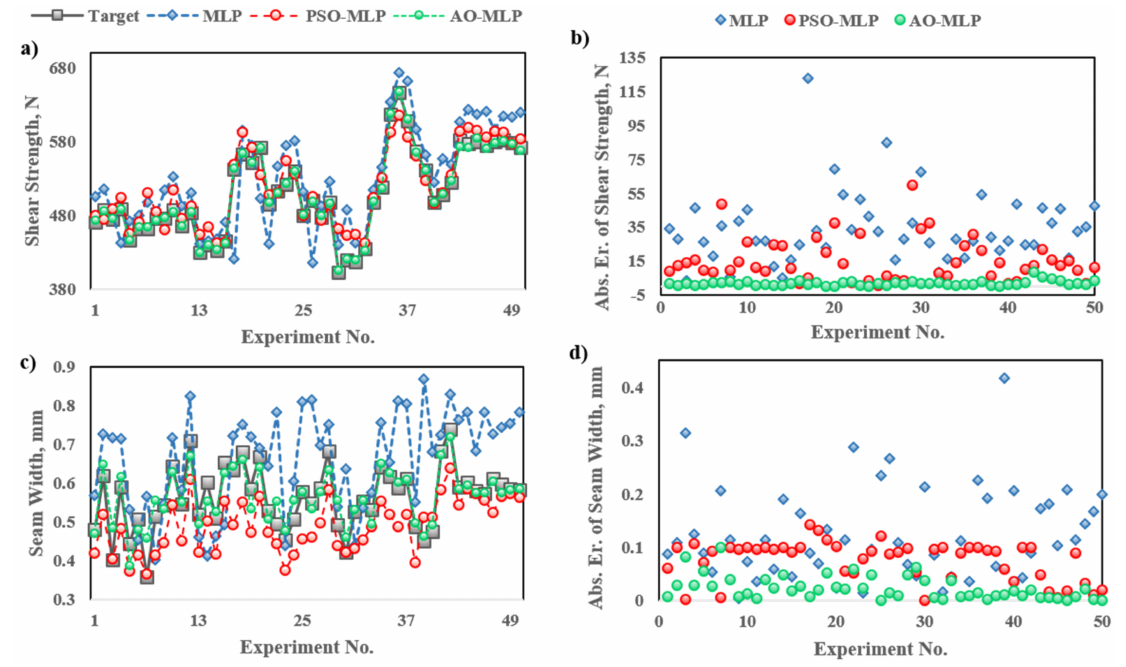
Figure 2. Target and predicted data using MLP, PSO-MLP, and AO-MLP for: ( a ) data of shear strength;